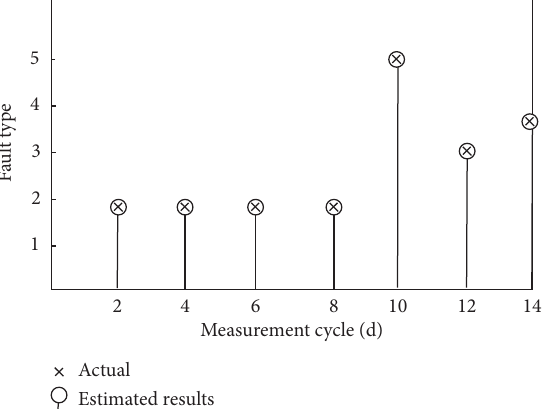
Figure 4: IEEE 14 node power system state estimation results.